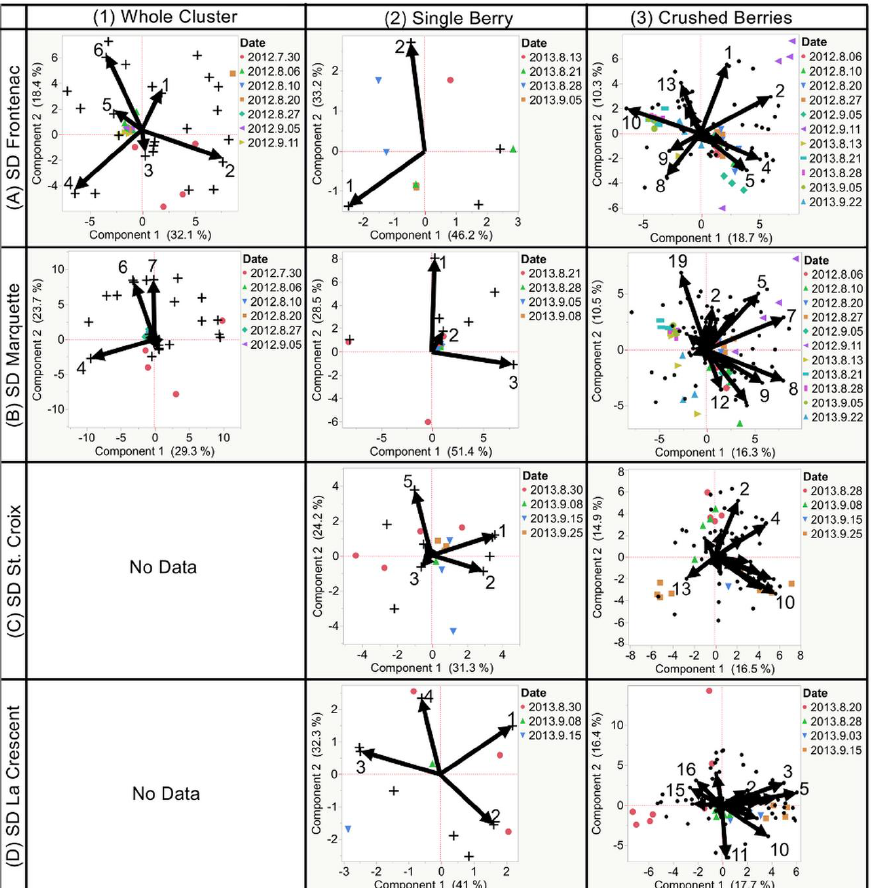
Figure A2. Results of a PCA on VOCs emitted from South Dakota cold-hardy grapes by sampling methods (1) whole cluster, (2) single berry, (3) crushed berries, and cultivars ( A ) Frontenac, ( B ) Marquette, ( C ) St. Croix, ( D ) La Crescent. These plots show the relationships of grape maturity during ripening (Date) to each other and the associations among the most representative variable from cluster analysis. Key: 1A: 1 = 2-Methyl-3-penten-2-one, 2 = Nonanal, 3 = Benzyl alcohol, 4 = Toluene, 5 = Acetic acid, 6 = 3-Phenyl-2-propenal; 1B: 1 = 1-Hexadecanol, 2 = 2-Ethyl-1-Hexanol, 3 = 1-Pentanol, 4 =